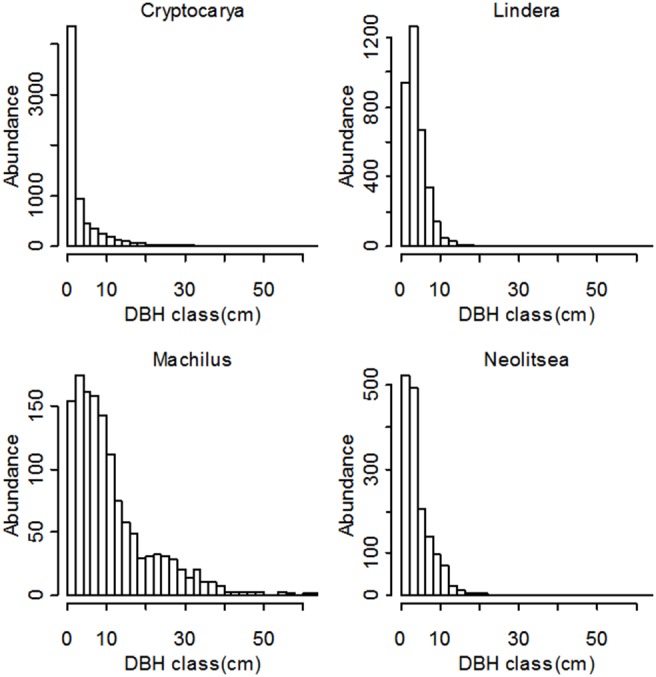
Size (DBH) class of the four genera including species from Table 1.